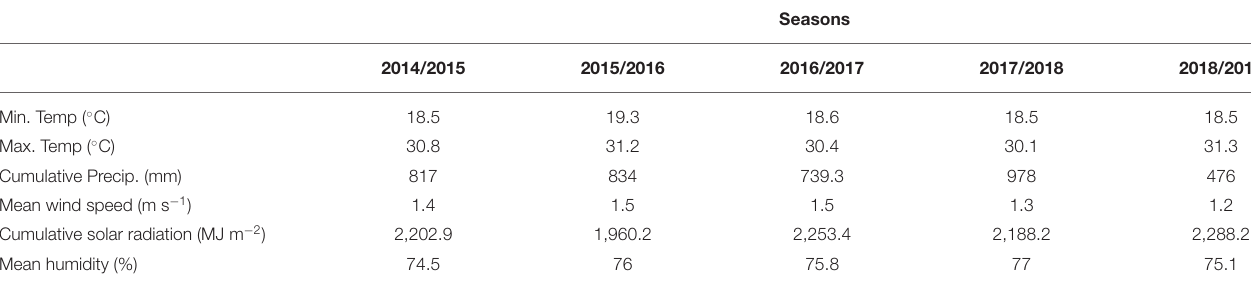
TABLE 1 | Summary of mean min and max temperature and cumulative rainfall in each cropping season.